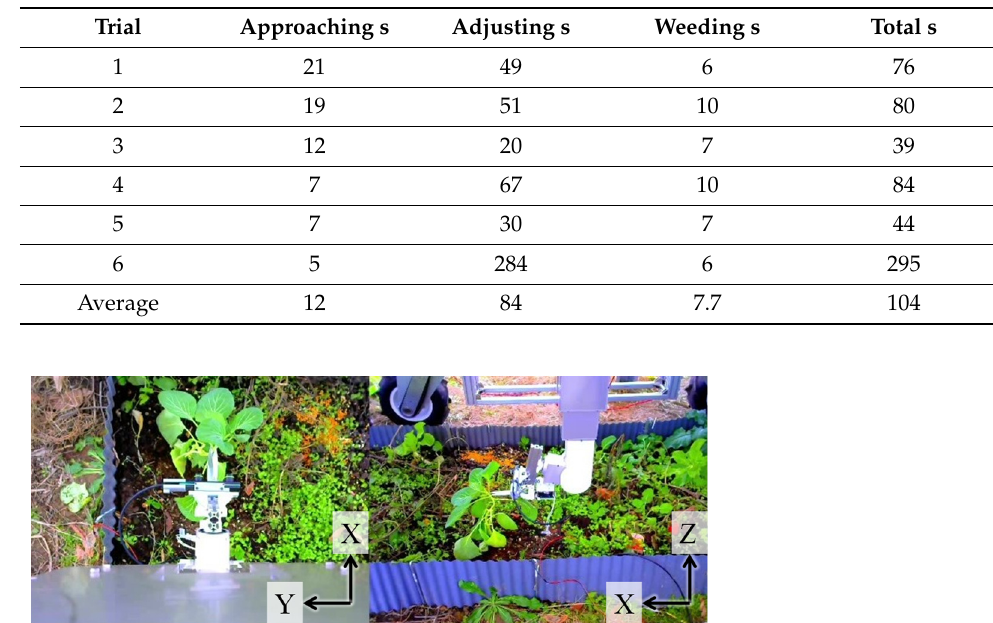
Table 2. Sowing force measurement result.